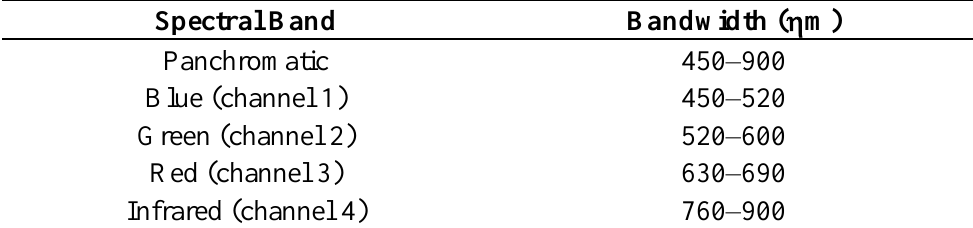
Table 1. Spectral ranges of the QuickBird